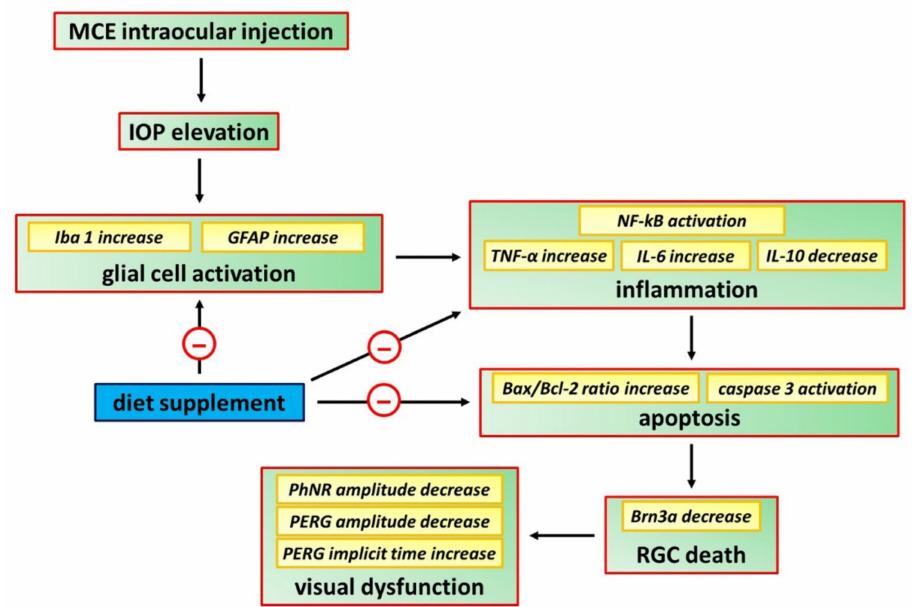
Figure 8. Schematic diagram showing possible mechanisms through which the diet supplement counteracts RGC death thus preserving, at least in part, retinal function. MCE leads to IOP elevation that, in turn, generates a downstream cascade that, through the induction of gliosis and inflammation, triggers RGC degeneration by apoptosis and visual dysfunction. The diet supplement, acting as a direct neuroprotectant, reduces gliosis, inflammation and apoptotic processes thus sparing RGCs from death and counteracting visual dysfunction.